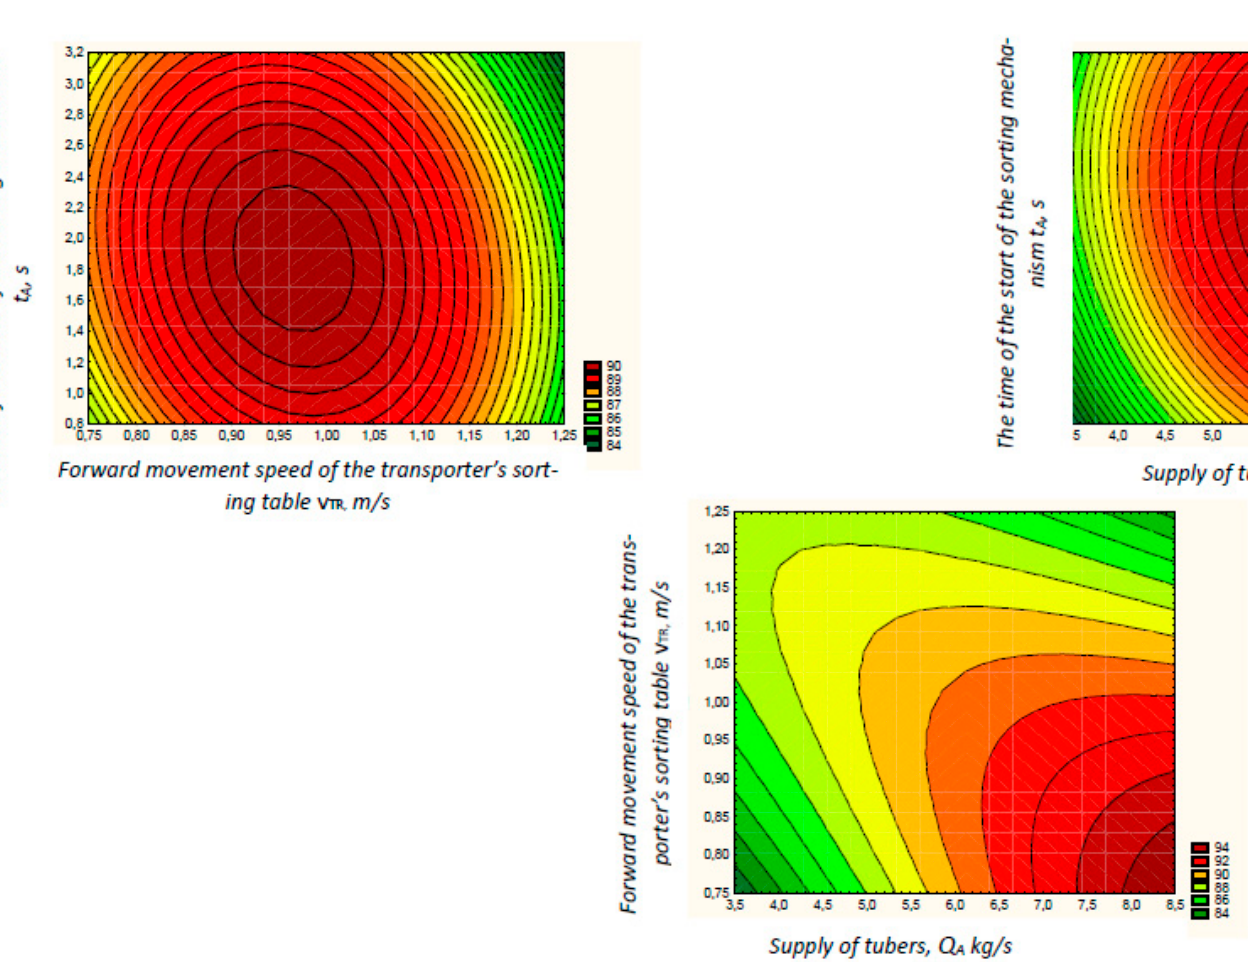
Figure 10. Two-dimensional dissection of the response surface, describing the dependence of the accuracy of the sorting of the tubers on the selected factors: forward movement speed of the transporter’s sorting table (v TR ), supply of tubers (Q A ) and the time of the start of the sorting mechanism (t A ).